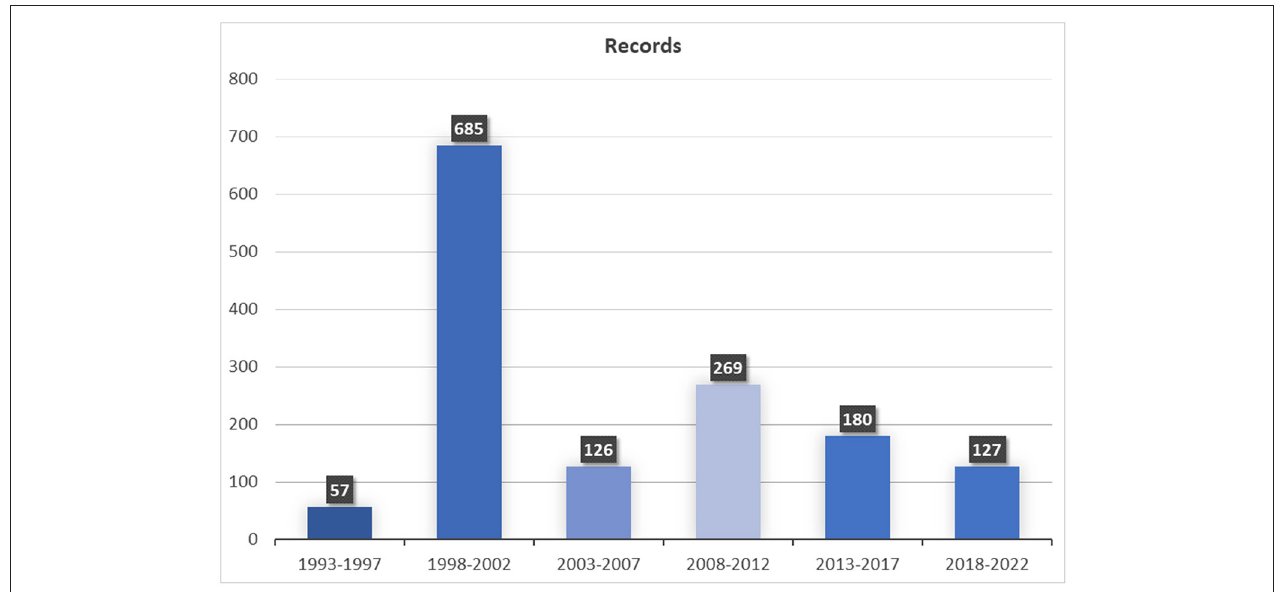
FIGURE 3 | Chronology of the field